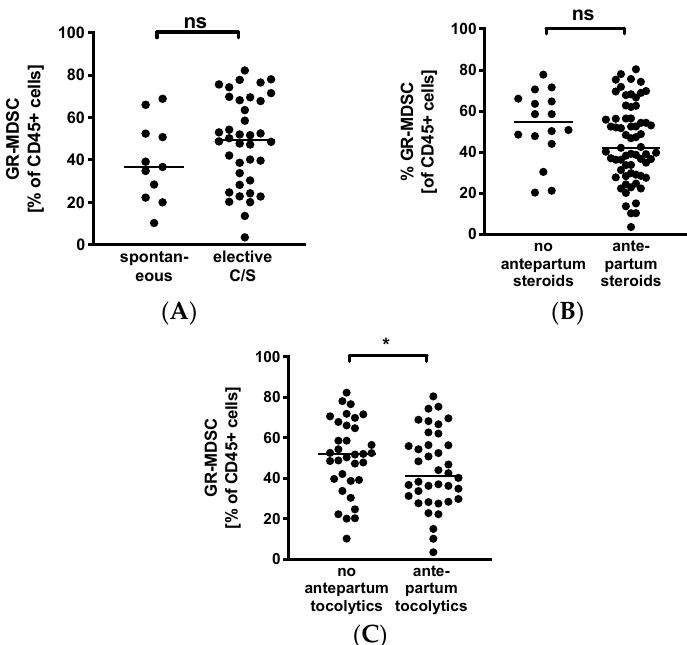
Figure 3. Quantification of GR-MDSC in the breast milk of preterm infants (maternal characteristics). Milk cells were isolated from the breast milk of mothers of preterm infants during the first five weeks of life. Percentages of GR-MDSC of total CD45 + leucocytes were determined by flow cytometry. The mean percentage of BM-MDSC was calculated. ( A – C ) Scatter diagrams showing the expression of GR-MDSC in breast milk of women who delivered spontaneously and of women who delivered by elective cesarean section ( A ), in women who received antepartum steroids and who did not ( B ), and in women who received antepartum tocolytics and who did not ( C ). n = 11–65, * p < 0.05, ns not significant, Mann–Whitney test.